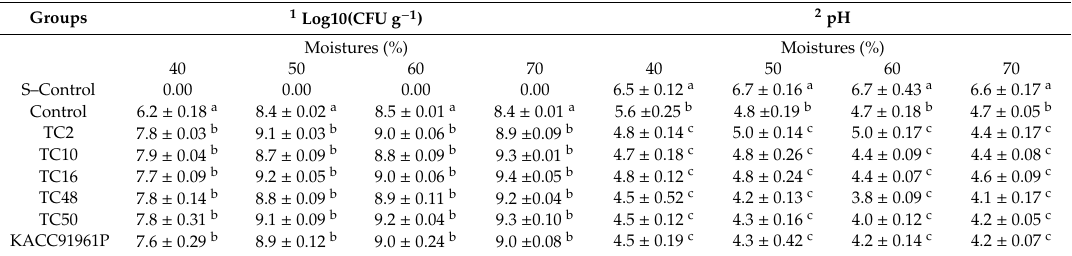
Table 1. Average microbial population and pH of triticale silages as a function of the microbial inoculants after fermentation.